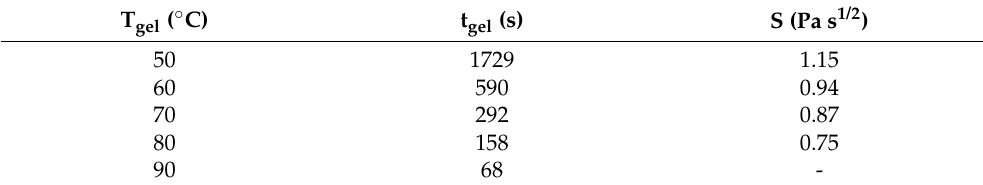
Table 2. Critical gel times and the strength of the hydrogel at gelation for the system between N - furfuryl chitosan (1 %- w/w ) and PEG(mal) 2 -7500 with R = 0.25. T gel (°C) t gel (s) S (Pa s 1/2 )